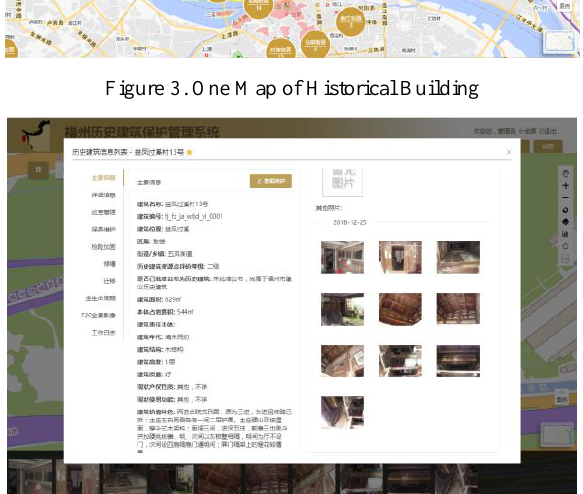
Figure 4. Information Display of Historical Building